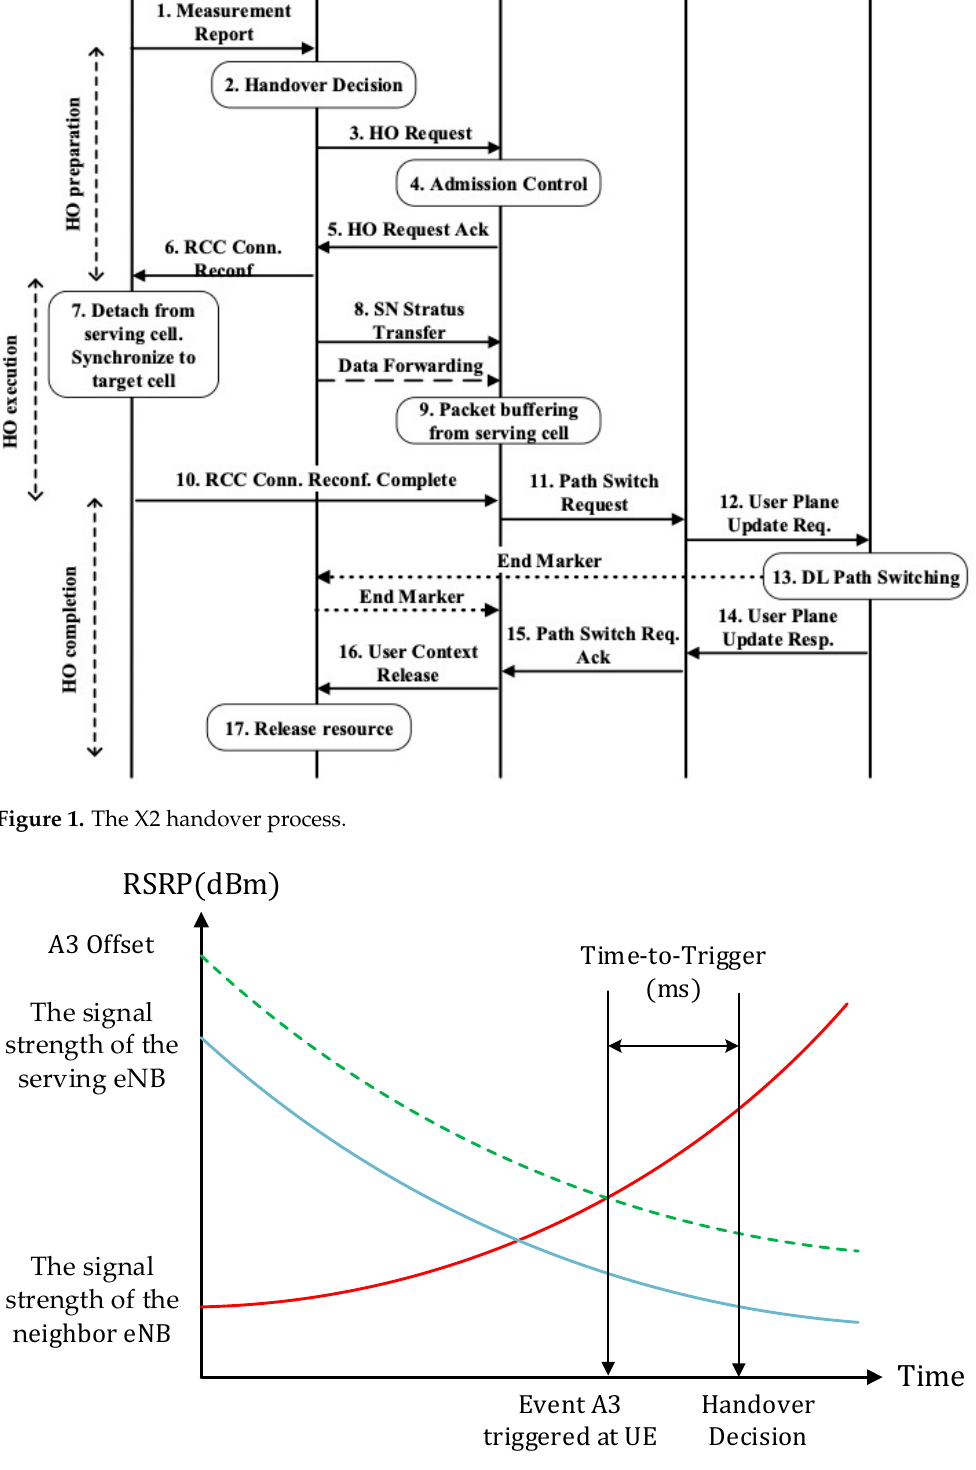
Figure 2. The event A3 handover